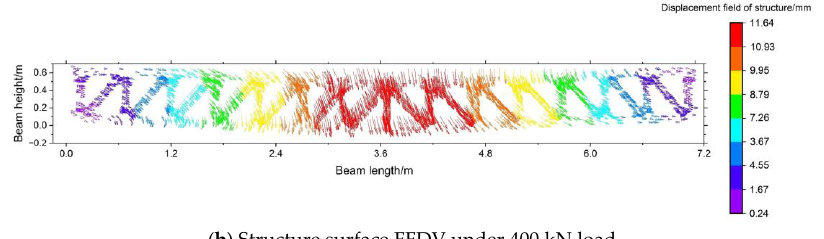
Figure 19. Structure surface FFDV under D02 condition.